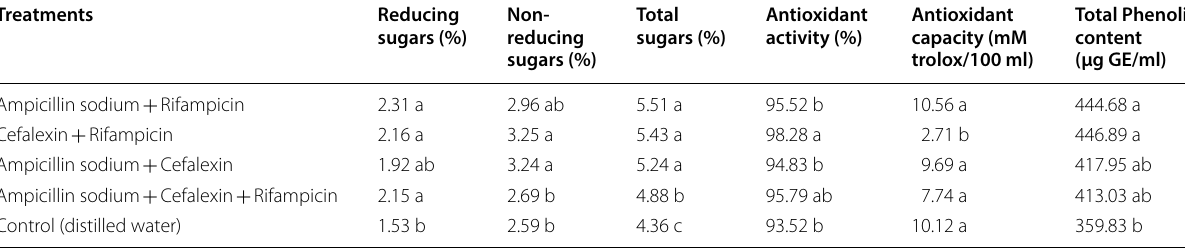
Means within a column with different letters are significantly different at P